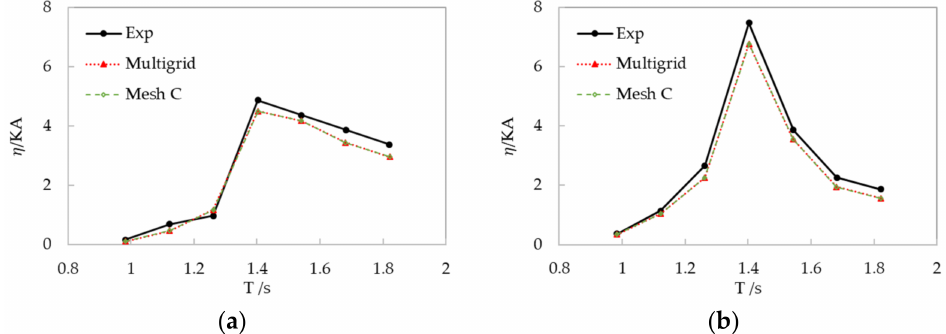
Figure 13. Roll RAOs obtained by numerical simulations with the multigrid approach and experi- mental data. ( a ) Damaged condition; ( b ) Intact